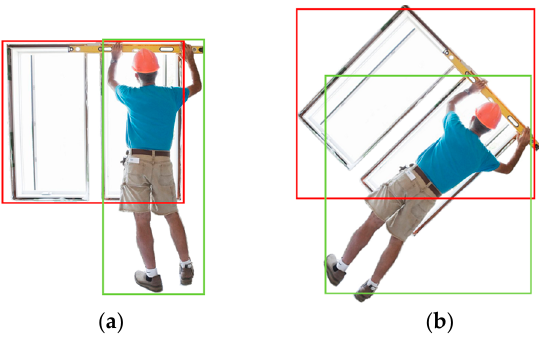
Figure 2. Comparison of recognition results before ( a ) and after ( b ) camera reversal.